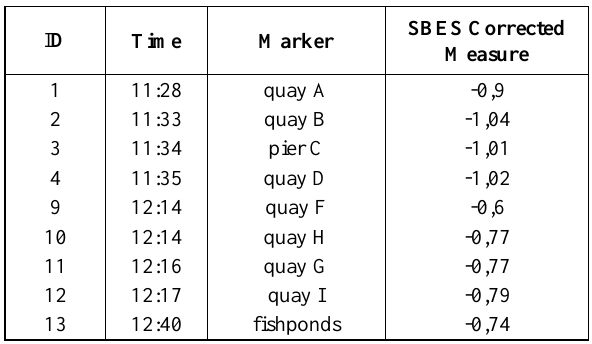
Table 6. Table of archaeological remains submersion: ID column is a univocal counter; Time is precise hour of measure; Marker is the archaeological remain abbreviation; SEBES corrected measure is the Echo sounder the recorded data corrected by means of the methodology described in 2.4.2 paragraph.